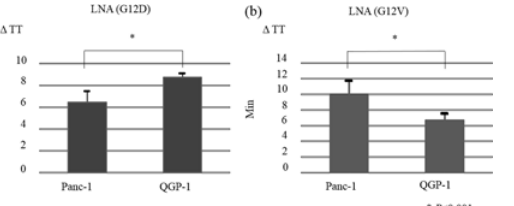
Fig 5. Detection of KRAS mutation subtypes using PNA-LNA mediated LAMP. (a) By using an LNA primer with a sequence complementary to that encoding the G12D mutation, cDNA from the Panc-1 cell line that expresses the KRAS G12D mutant was amplified more rapidly than cDNA from the QGP-1 cell line that expresses the KRAS G12V mutant ( P < 0.01). (b) Conversely, by using an LNA primer with a sequence complementary to that encoding the KRAS G12V mutation, cDNA from the QGP-1 cell line that expresses the KRAS G12V mutant was amplified more rapidly than cDNA from the Panc-1 cell line that expresses the KRAS G12D mutant ( P < 0.01). Δ TT is defined in the